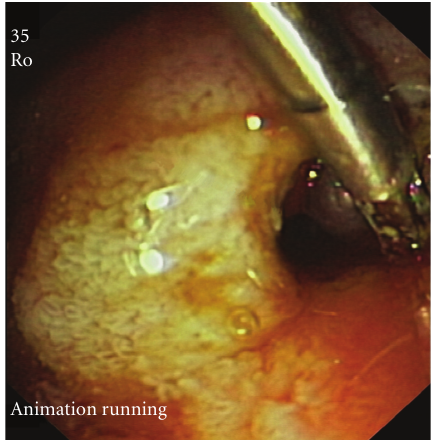
Figure 3: After clip placement and sclerosis, a vessel behind the clip is visible